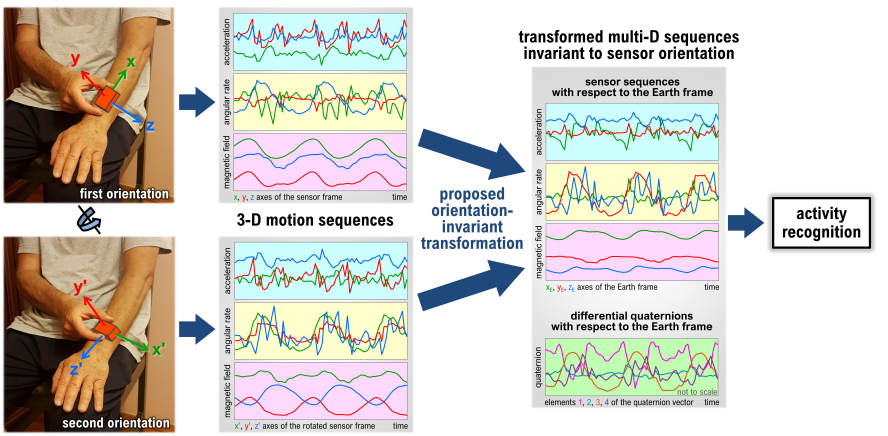
Figure 1. An overview of the proposed method for sensor unit orientation